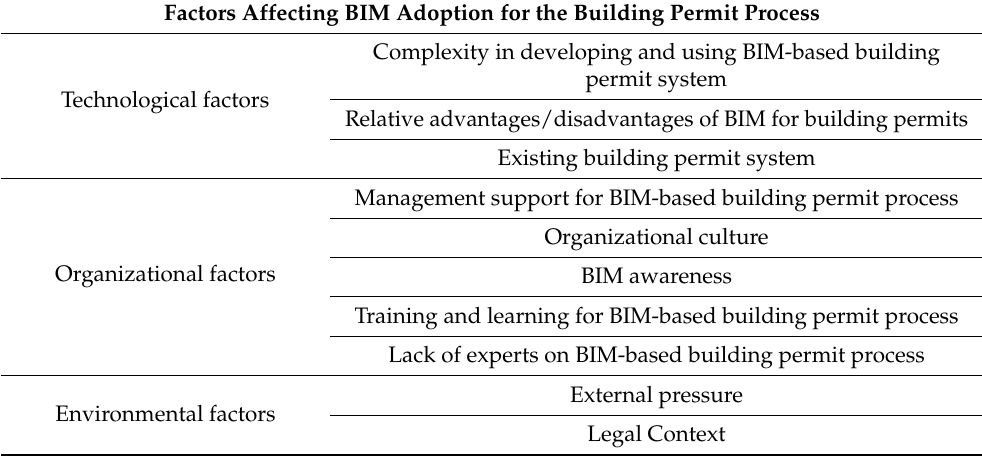
Table 4. Factors affecting BIM adoption for the building permit